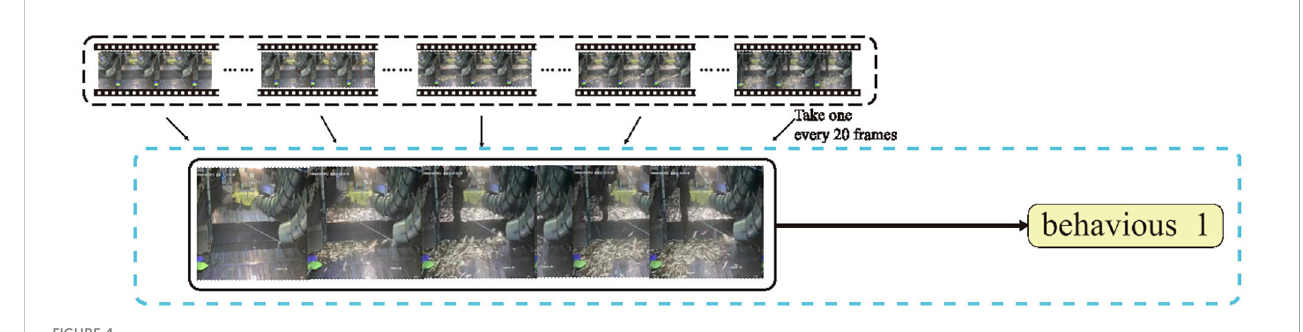
FIGURE 4 Datasets ’ optimization method and optimized datasets ’